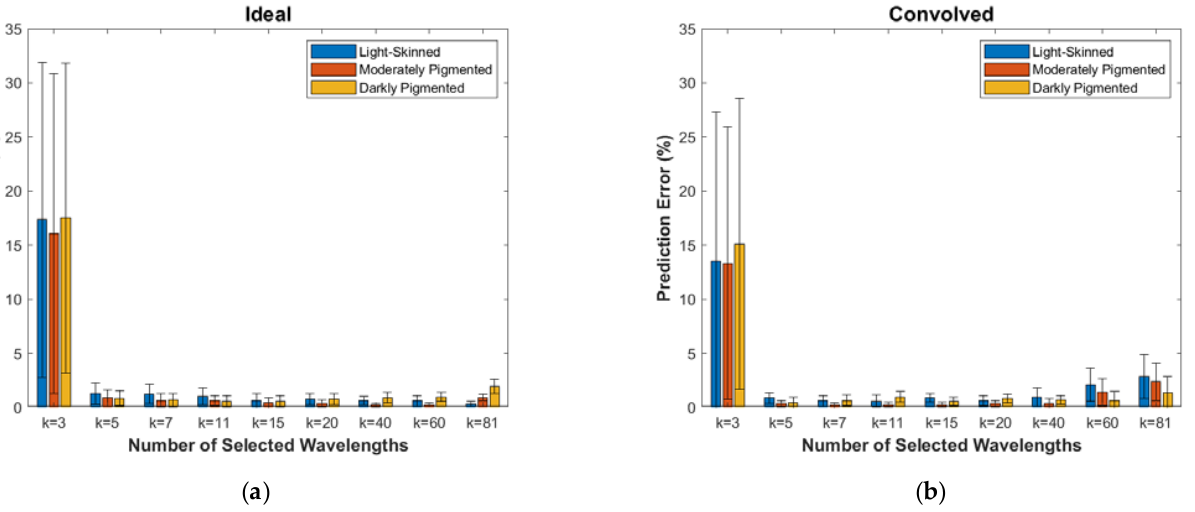
Figure 7. Prediction errors for the Monte Carlo validation dataset separated by melanin fraction representing light-skinned (<0.10), moderately pigmented (0.10–0.30), and darkly pigmented (>0.30) adults. Mean values and one-standard-deviation error bars are given for ( a ) the ideal case and ( b ) the convolved